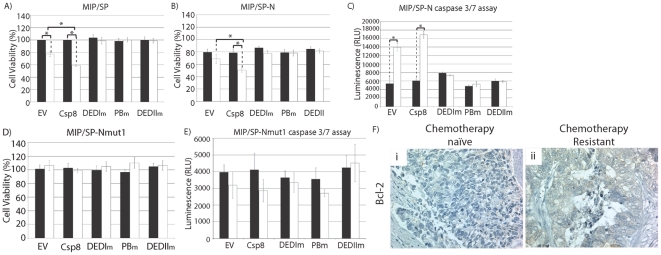
Interaction between the N-terminus of both caspase 8 and SPARC are required to reduce cell viability and enhance apoptosis.
A–B) Cell viability further decreased in MIP/SP and MIP/SP-N after transfection with wild-type caspase 8 and 5-FU treatment, relative to empty vector (EV, control): MIP/SP: 77.2±3.8 (EV) vs. 59.1±1.5% (caspase 8) (p<0.005); MIP/SP-N: 68.8±4.8 (EV) vs. 50.6±3.6% (caspase 8) (p = 0.04). Transfection with any of the caspase 8 mutants eliminated their response to 5-FU, not only in terms of cell viability, but apoptosis (C). In cells overexpressing mutant SP-N (MIP/SP-Nmut1), transfection with caspase 8 was incapable of decreasing cell viability (D) or increasing apoptosis (E). Results represent mean ± s.e. (n = 3 independent studies). *p<0.05, Student's t-test. F) Bcl2 expression of clinical specimens of human CRCs obtained from the same individual following primary tumor resection (chemotherapy-naïve) and disease recurrence post-chemotherapy (chemotherapy-resistant) (paraffin-embedded 6 µM sections).